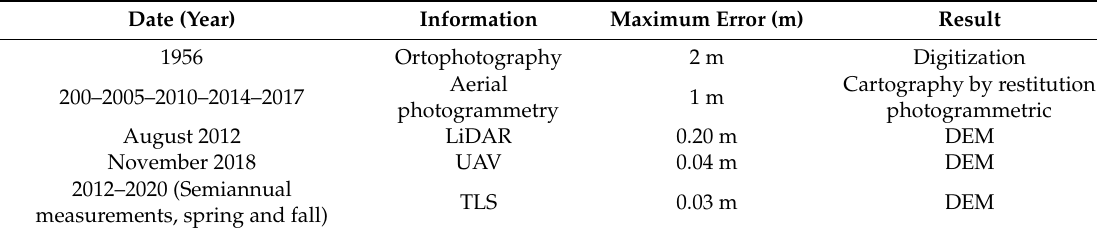
Table 2. General information of initial data and obtained results for Gerra